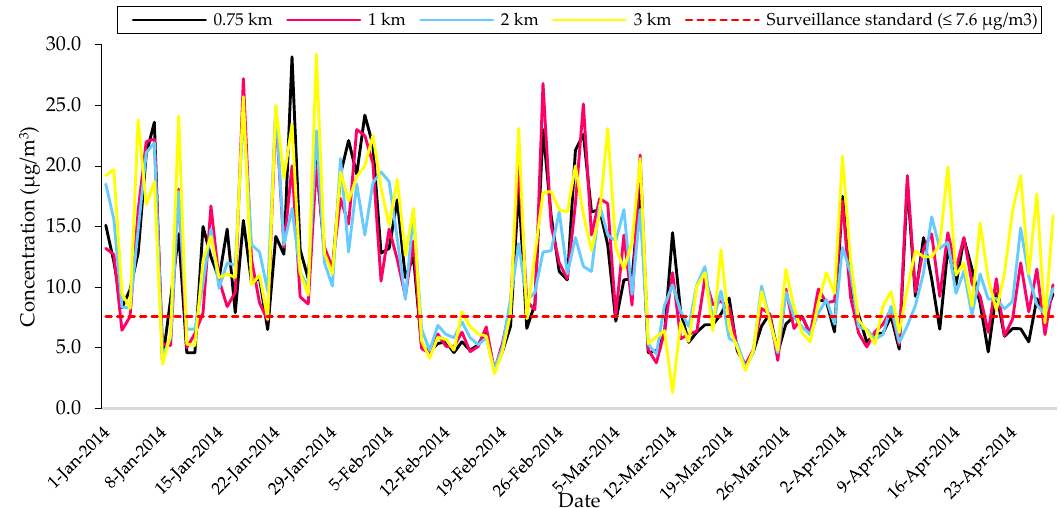
Figure 3. Daily maximum values of benzene concentrations from different grid resolutions .